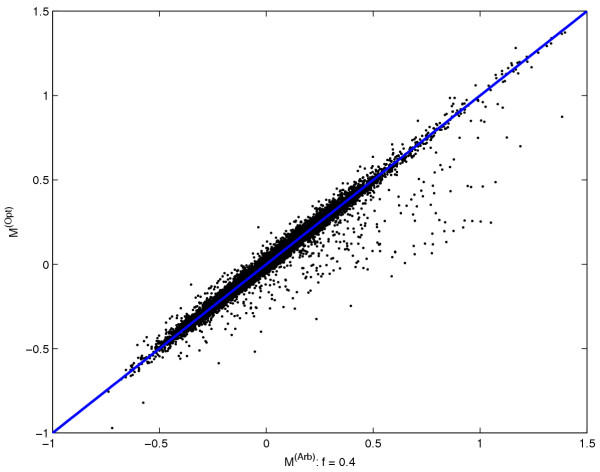
(M(Arb), M(Opt))-Scatterplot analysis of BT-474 self versus self data This plot compares the calibrated ratios obtained by LOWESS (d = 1) with the arbitrary choice of fk = 0.4 for all print-tips compared to ratios obtained with optimized fk for each print-tip group. The line of unity slope that passes through the origin shows where all the points should lay if both calibration methods produced identical ratios. For this self versus self experiment, the group of points that lay under this line shows that the arbitrary fk may improperly under-normalize these points.